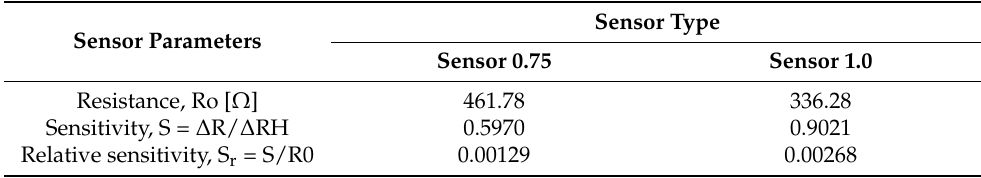
Table 1. Sensing parameters for 0.75 and 1.0 RH resistive sensors.